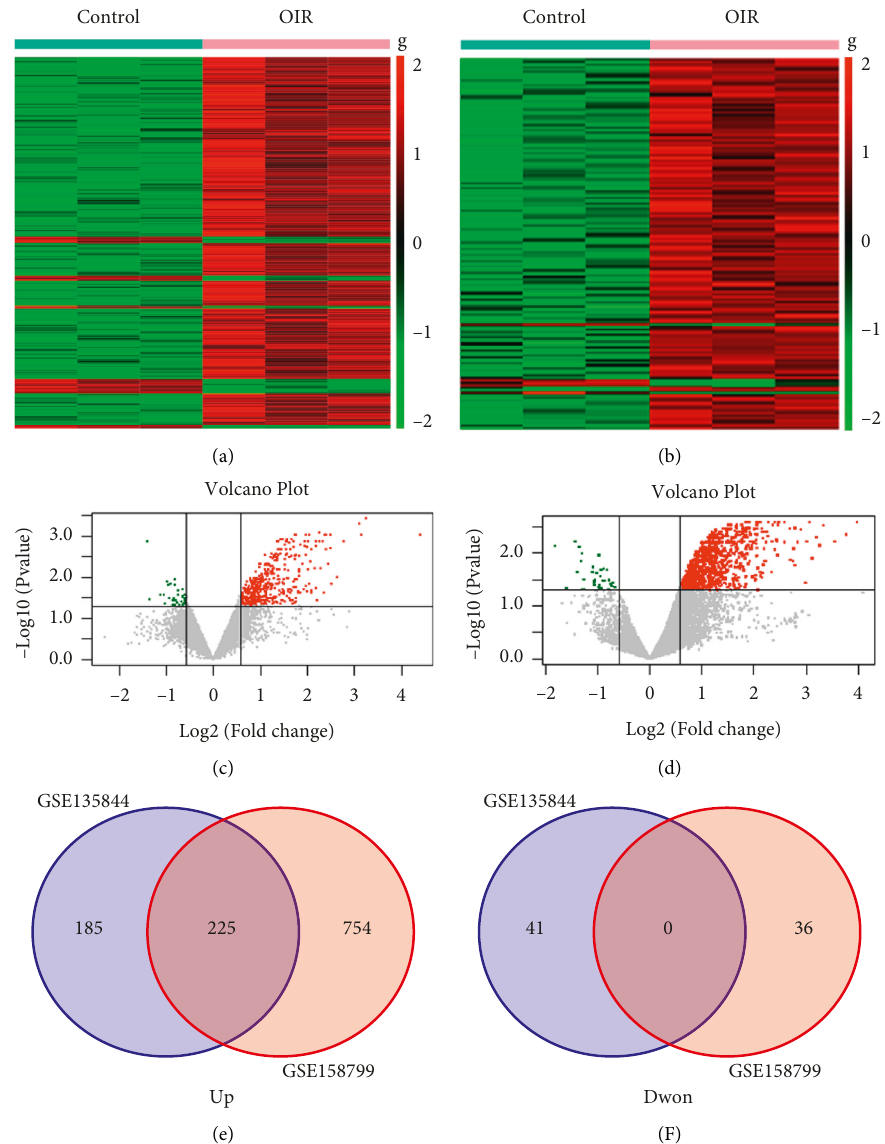
Figure 2: Heatmap of differentially expressed genes identified in (a) GSE158799 and (b) GSE135844. Legend on the top right indicates the log fold change of the genes; volcano plots of differentially expressed genes. (c) GSE158799 and (d) GSE135844. Data points in red represent upregulated, and data points in green represent downregulated genes. The differences are set as |log FC| > 0.585. Venn diagram of common differentially expressed genes from the two datasets. (e) 0 DEG was downregulated in the two datasets, and (F) 225 DEGs were upregulated in the two